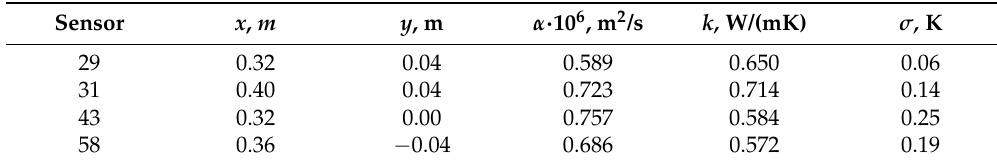
Table 1. Determined values of thermal parameters of the system.